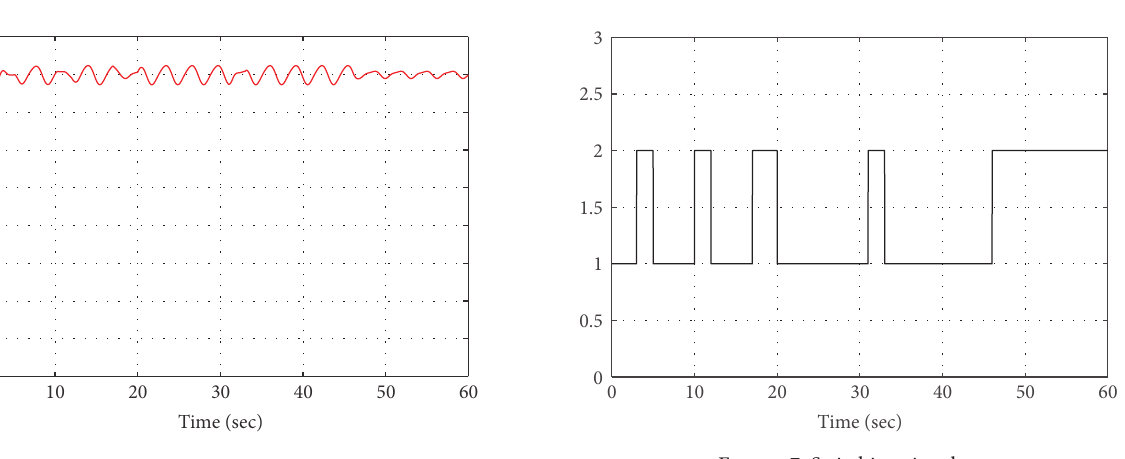
Figure 7: Switching signal 𝜎